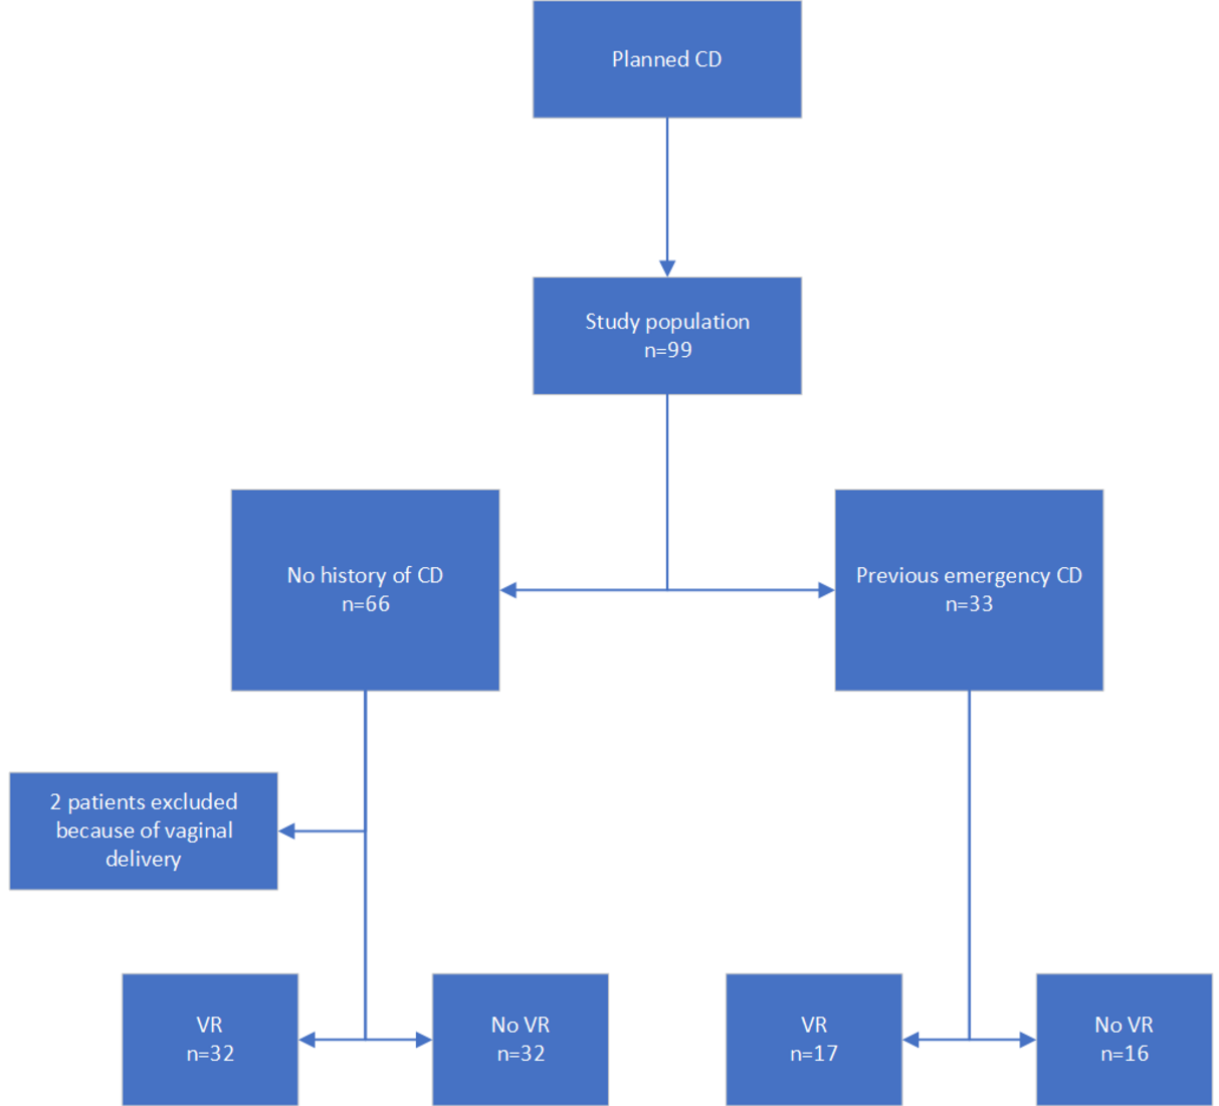
Figure 4. Flowchart of patient inclusion. CD: cesarean delivery; VR: virtual